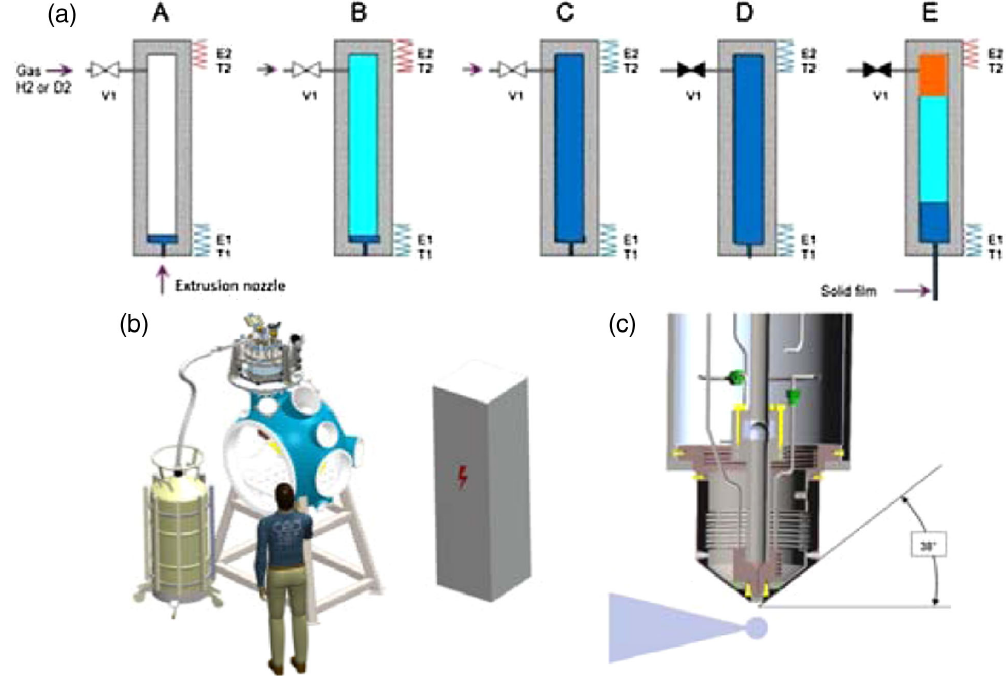
FIG. 1. (a) Different phases of the solid H 2 ribbon generation, (b) scheme of the ELISE installation at PALS, (c) sketch of the ELISE